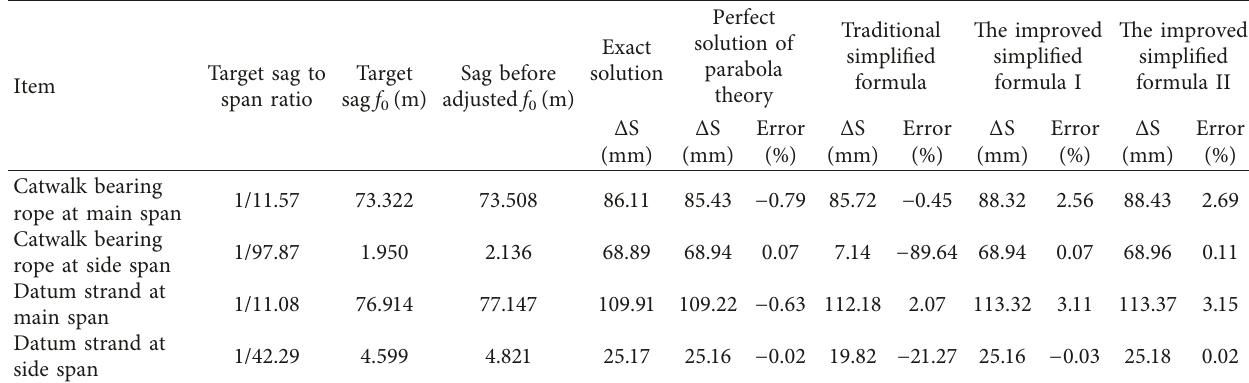
Table 5: The length adjustment of the datum strand and catwalk bearing rope.